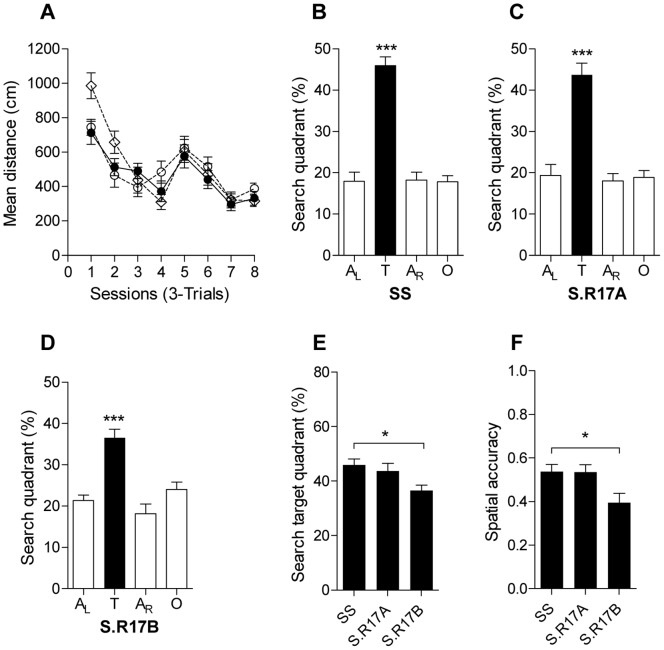
Testing of spatial learning and memory in Dhal S, S.R17A and S.R17B congenic male rats(A) Acquisition performance measured as mean distance in cm during the 24 trials (•, Dahl S; ◊, S.R17A; ○, S.R17B). Percentage distance traveled in quadrants (B, C, D, E) and spatial accuracy performance (F) during the probe trial after completion of Morris water maze training. Quadrants are: target (T), opposite (O), adjacent right (AR) and adjacent left (AL). *P = 0.02, ***P<0.001. Data represent means ± s.e.m. (one-way ANOVA followed by Holm-Sidak’s test for quadrant occupancy in the probe trial of the Morris water maze task and for spatial accuracy performance).